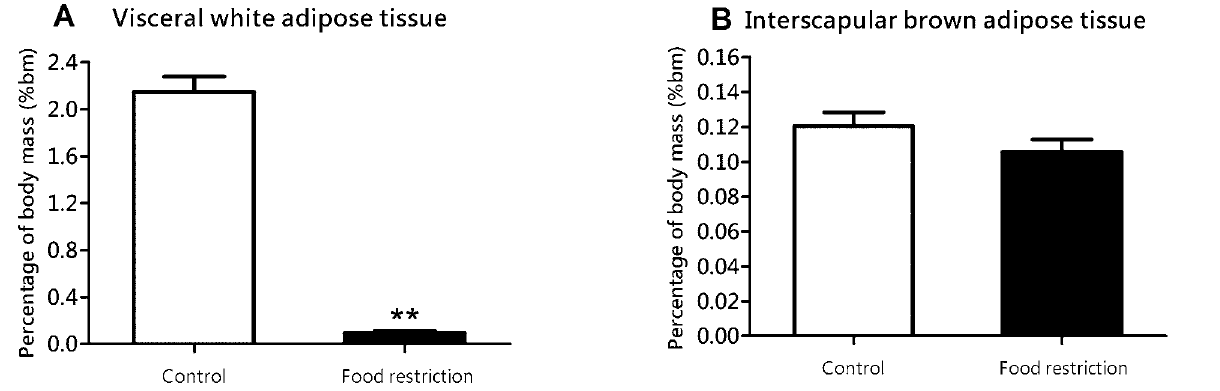
Figure 2. Visceral white adipose tissue (Figure 2A) and interscapular brown adipose tissue (Figure 2B) of the control and food restriction animals at the end of the six-week experiment; ** P<0.01 in relation to control